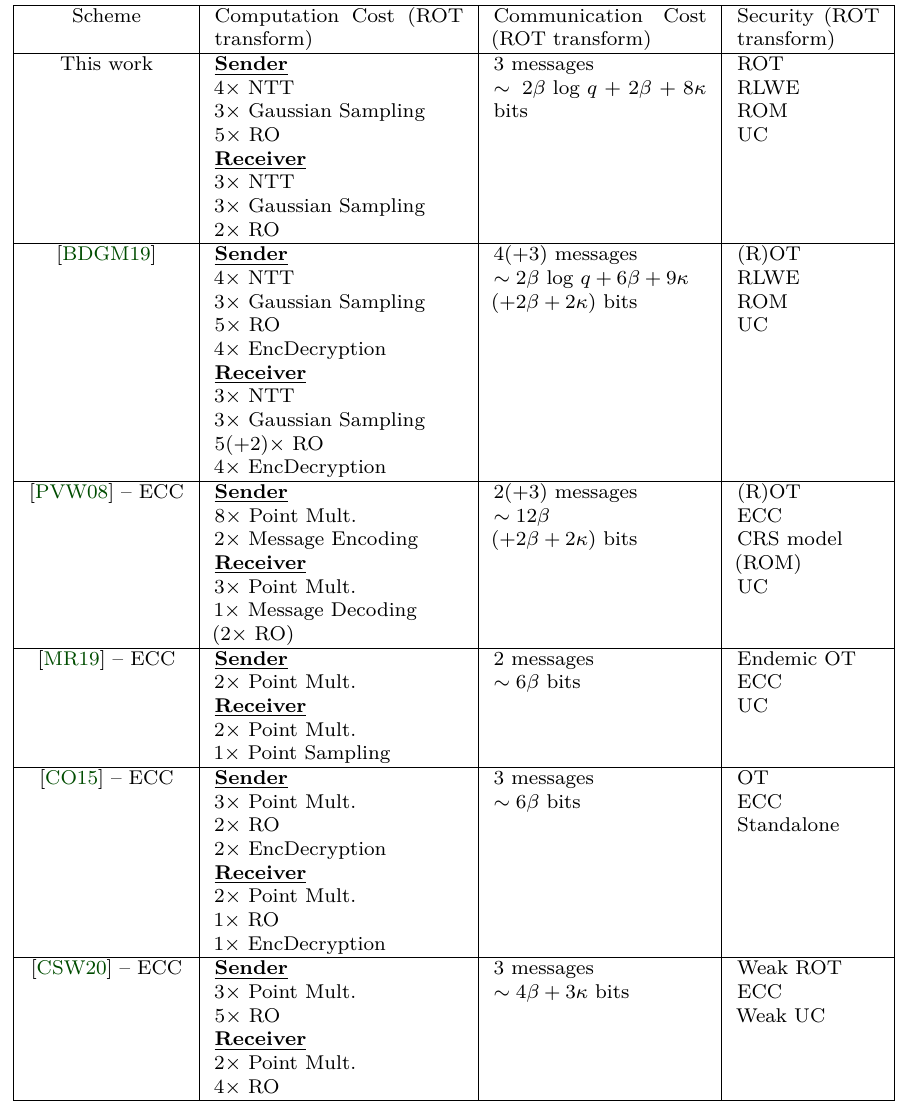
Table 1: Theoretical comparison between the proposed scheme and related art. Values in parenthesis refer to the operations/messages added by applying the transformation from Fig. 2 to [BDGM19, PVW08]. Communication cost was estimated based on the following factors. β corresponds to the cyclotomic polynomial degree underpinning RLWE schemes, to log p for ECs defined in F p underpinning ECC schemes, and to the bit-length of the messages outputted by the OT protocol. No point compression is considered ( i.e. exchanged EC points comprise 2 β bits). κ is a security parameter. Small constants (such as the transmission of c in Fig. 2) were